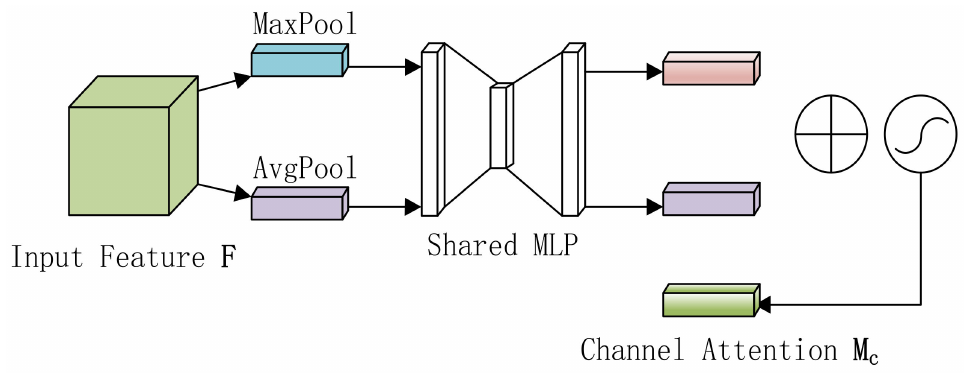
Figure 8. Channel Attention Structure.